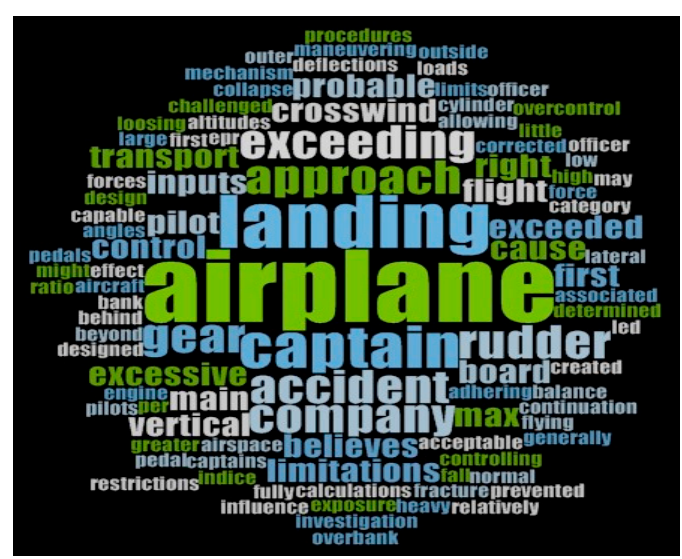
Figure 9. Tag cloud for Flying Outside the Envelope.